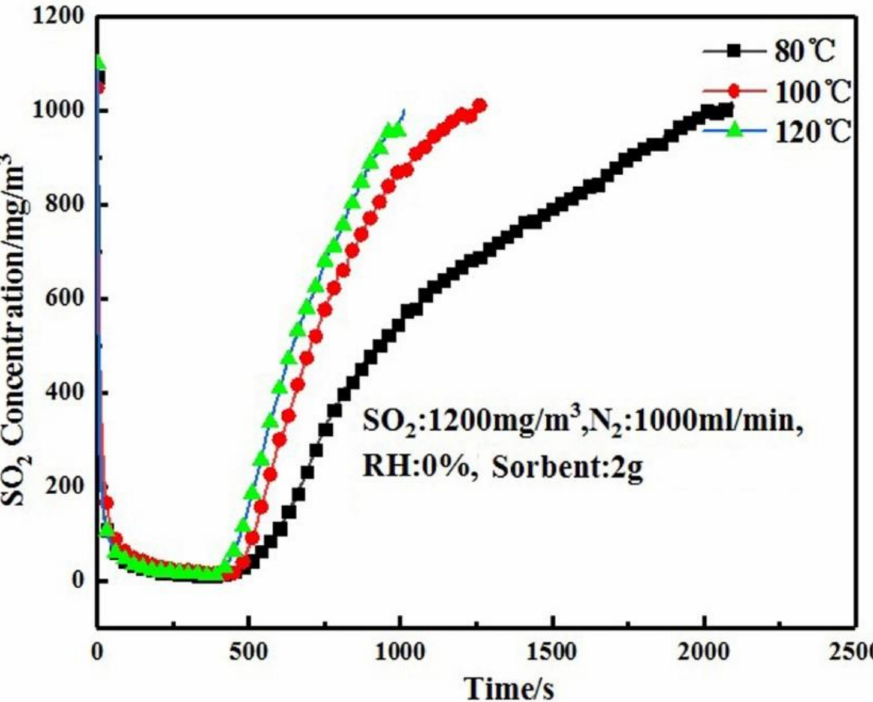
Figure 6. Effect of temperature on desulfurization performance of adsorbent (RH = 0%, SO 2 = 1200 mg/Nm 3